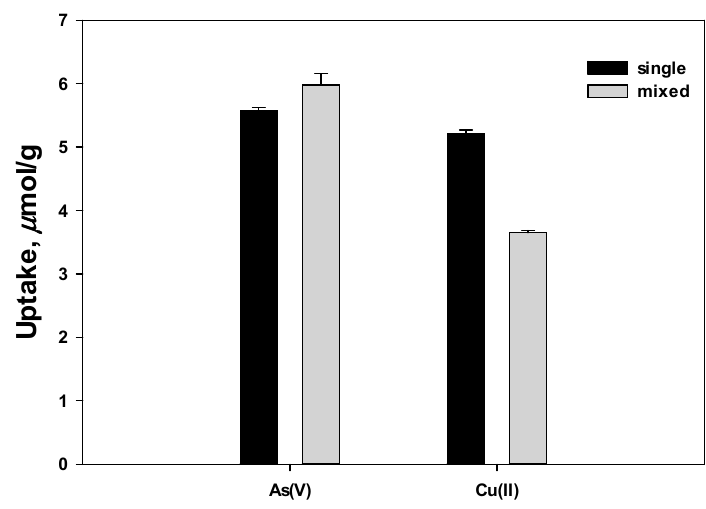
Figure 1. Removal uptake of Cu(II) and As(V) in a presence of single and/or mixed solution.